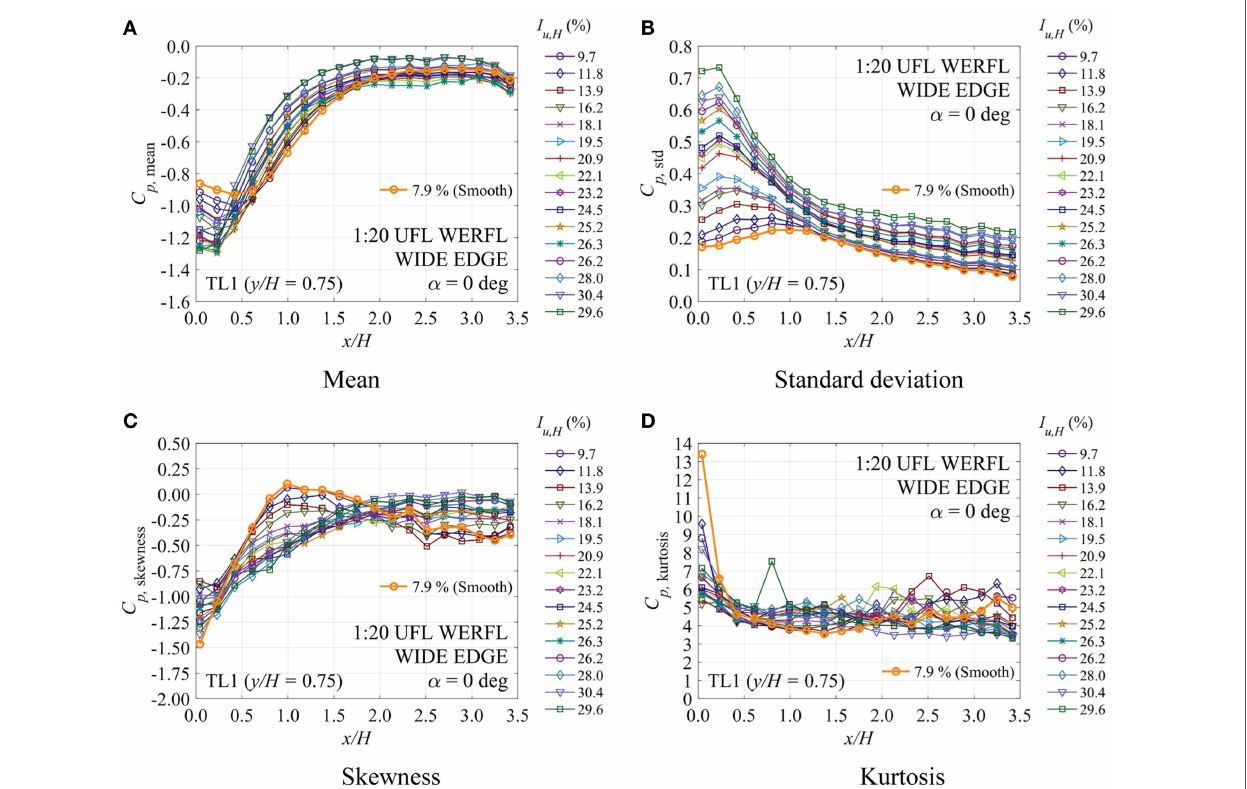
FIGURE 10 | Statistical properties of tap line 1 (TL1) on the 1:20 scale model for the wide edge element case. The distance along the tap line is normalized by the eave height of the model. (A) Mean, (B) SD, (C) skewness, and (D) kurtosis.